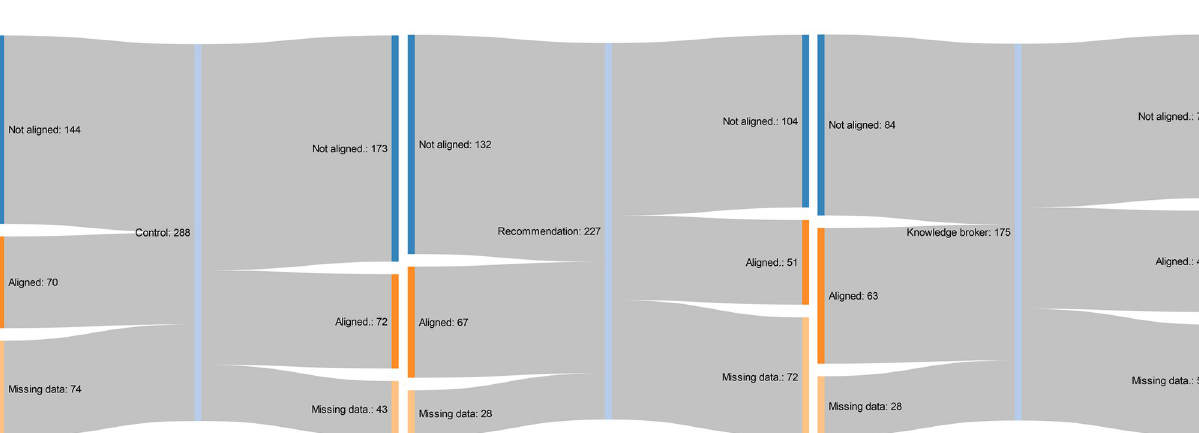
Fig 3. Flow of acute wards from baseline to follow-up policy recommendations alignment, by implementation strategy group.